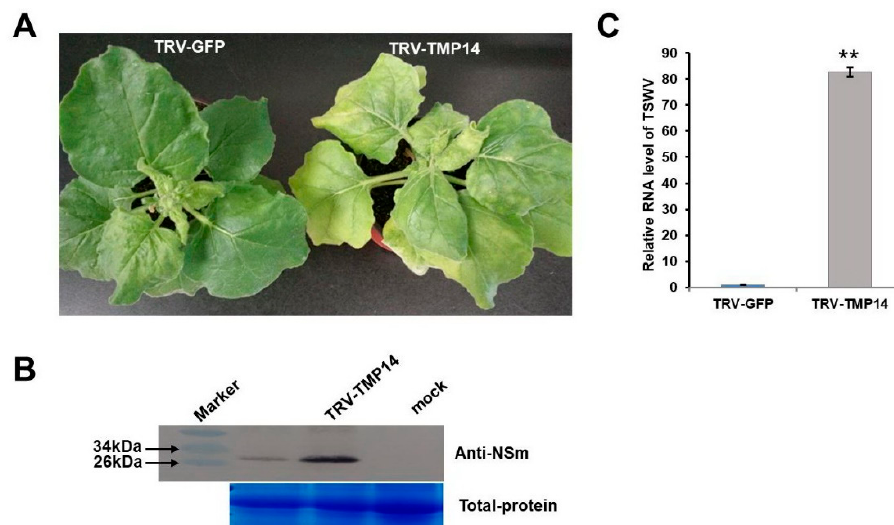
Figure 7. Accumulation of TSWV is upregulated in NbTMP14-silenced plants. ( A ) Symptoms of TRV2-GFP and TRV2-NbTMP14 plants after 15 days of TSWV infection. ( B ) Western blot detected the differing accumulation of TSWV between TRV2-GFP and TRV2-NbTMP14 plants. ( C ) RT-qPCR shows the accumulation of TSWV RNA between TRV2-GFP and TRV2-NbTMP14 plants. Bars represent the mean ± standard error, ** indicates significant differences (Student’s t -test, ** p < 0.01).